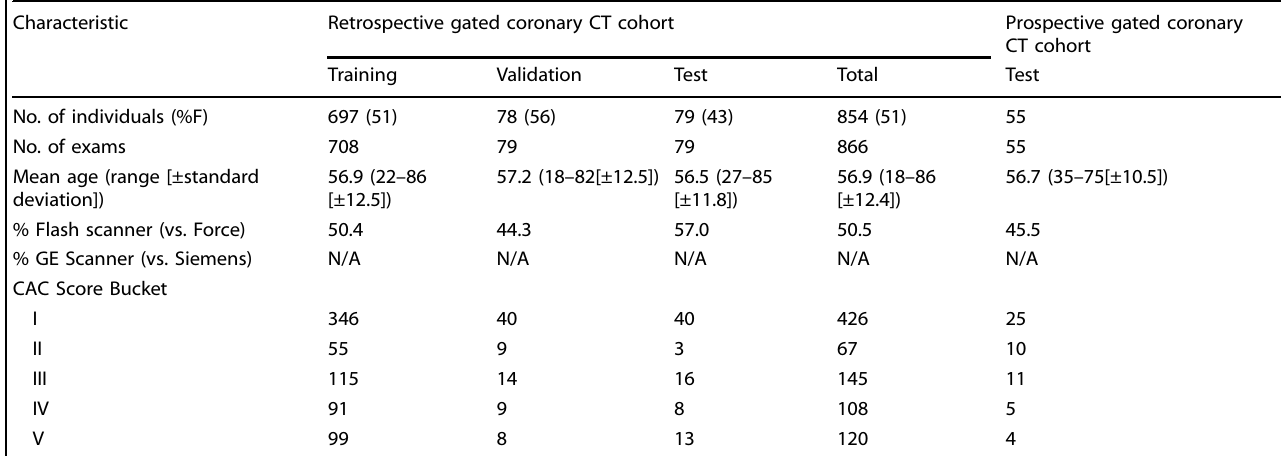
Table 1. Cohort demographics and statistics for gated